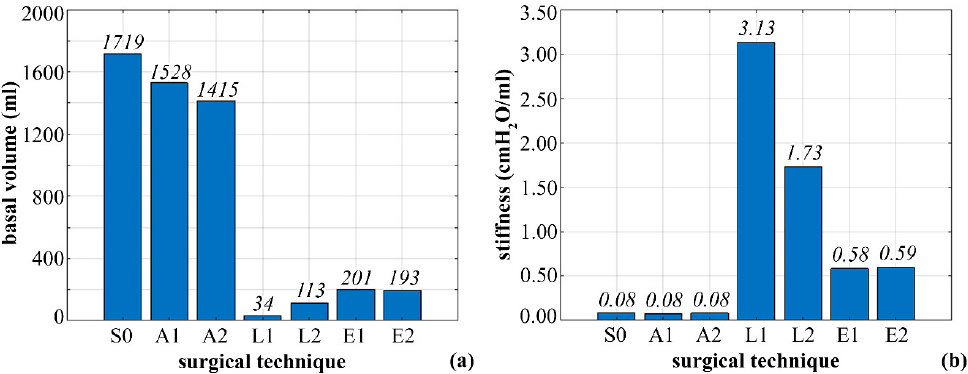
Figure 5. Computational results from simulations of stomach inflation (physiological stomach S0; postsurgical stomach with laparoscopic adjustable gastric banding A1 and A2, laparoscopic sleeve gastrectomy L1 and L2, and endoscopic sleeve gastroplasty E1 and E2): comparison of stomach basal volumes ( a ) and stiffness ( b ).